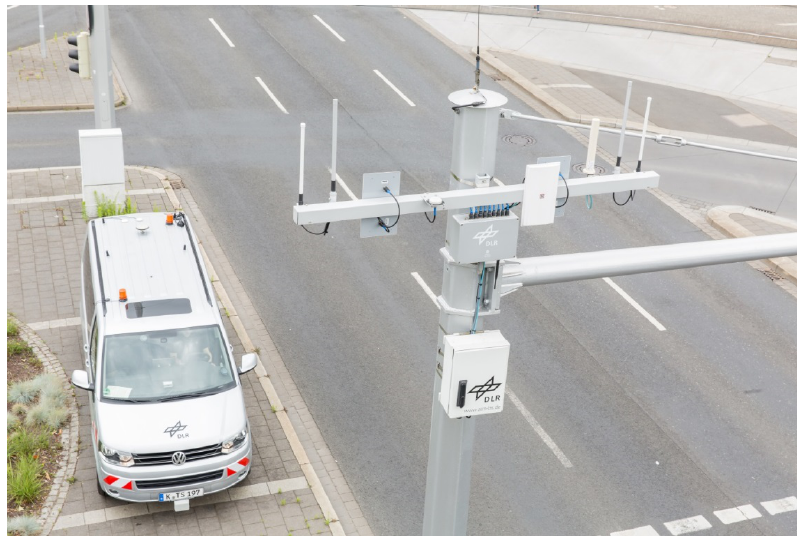
Figure 4: Reference Vehicle